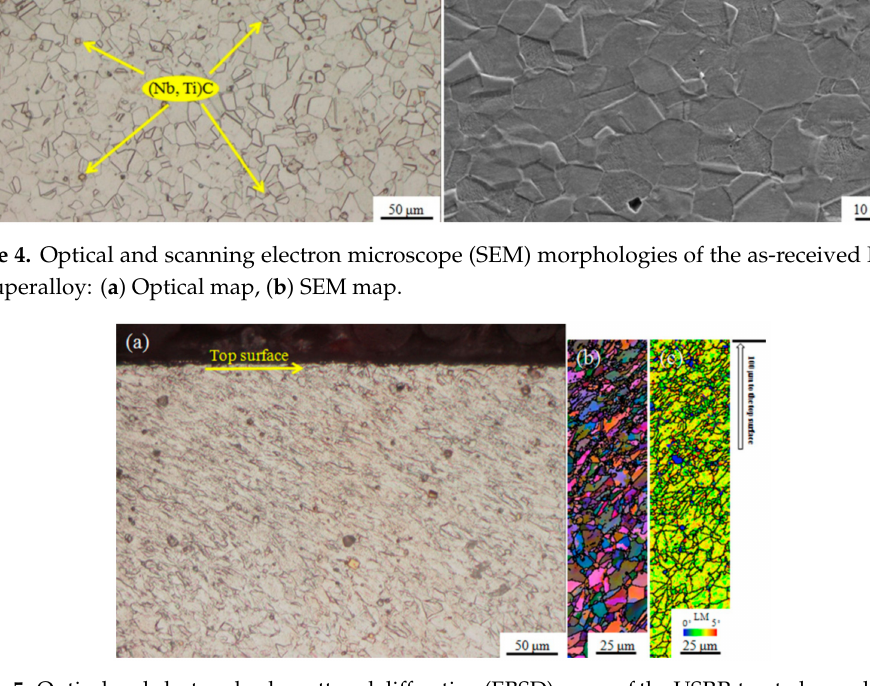
Figure 5. Optical and electron back-scattered di ff raction (EBSD) maps of the USRP-treated samples prior to hot compression test: ( a ) Optical map, ( b ) EBSD map of all Euler angles, ( c ) Local mis-orientation (LM)